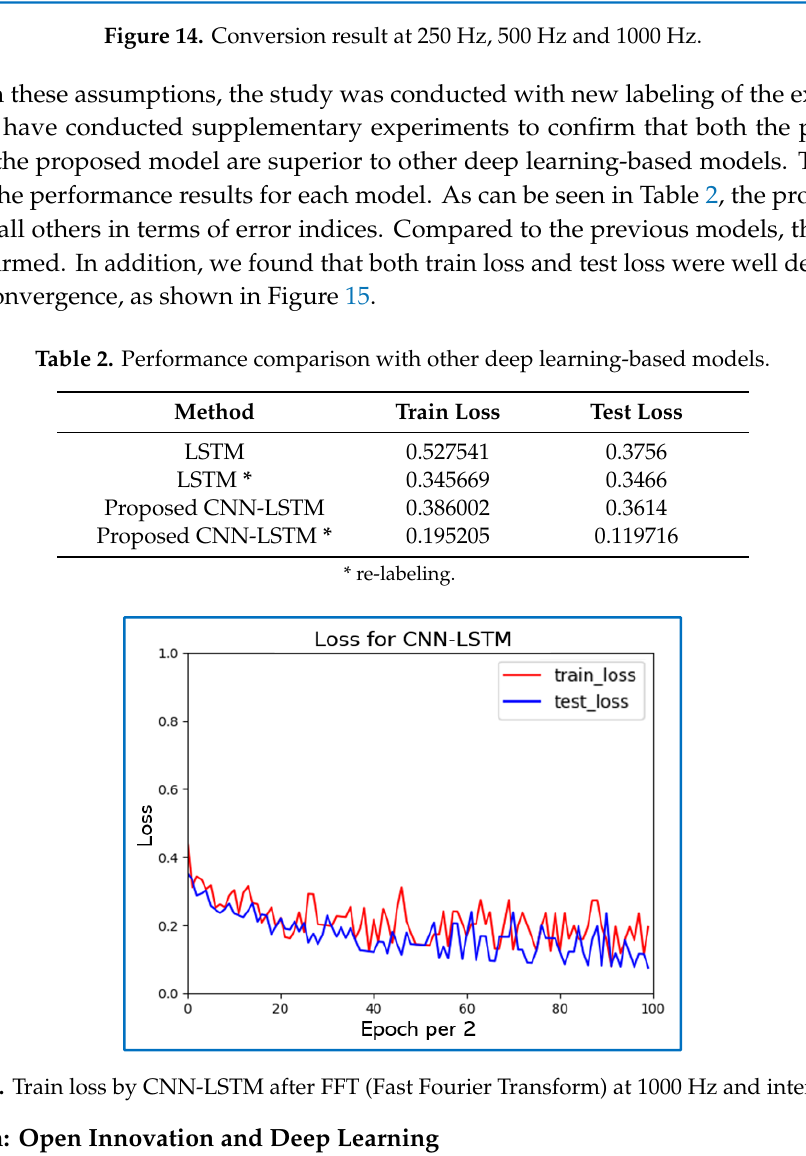
Figure 14. Conversion result at 250 Hz, 500 Hz and 1000 Hz.